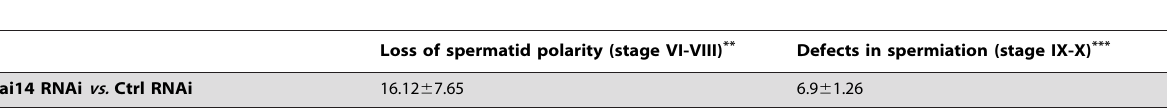
Table 3. Changes in the status of spermatogenesis in the rat testis following a knockdown of Rai14 by RNAi * .